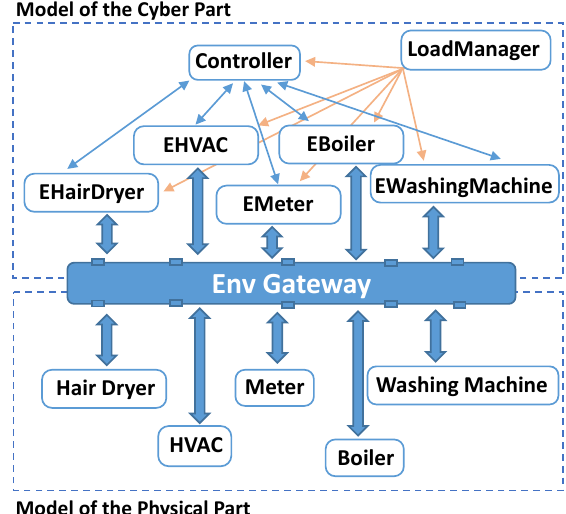
Figure 1. The architecture of the considered